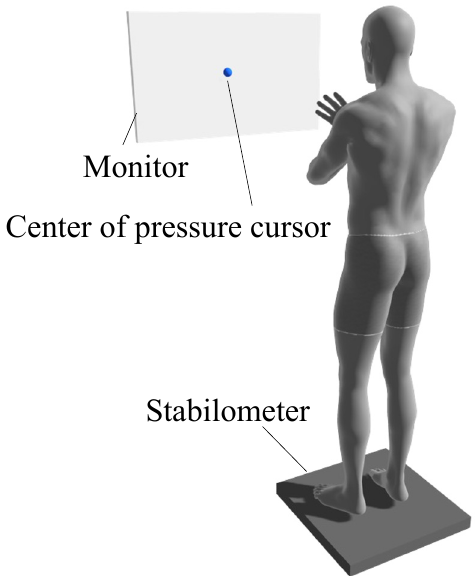
Figure 2. The participants performed a standing postural control task by standing on foam rubber placed on a stabilometer with both arms folded in front of their chest. The participants wore an electroencephalogram on their heads. A monitor was placed in front of each participant, which displayed only the center of the pressure cursor at that time.